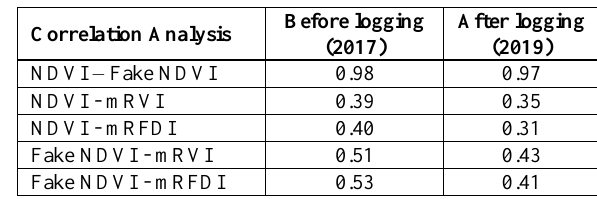
Table 3. The Pearson's correlation coefficient (R) between the vegetation indices.